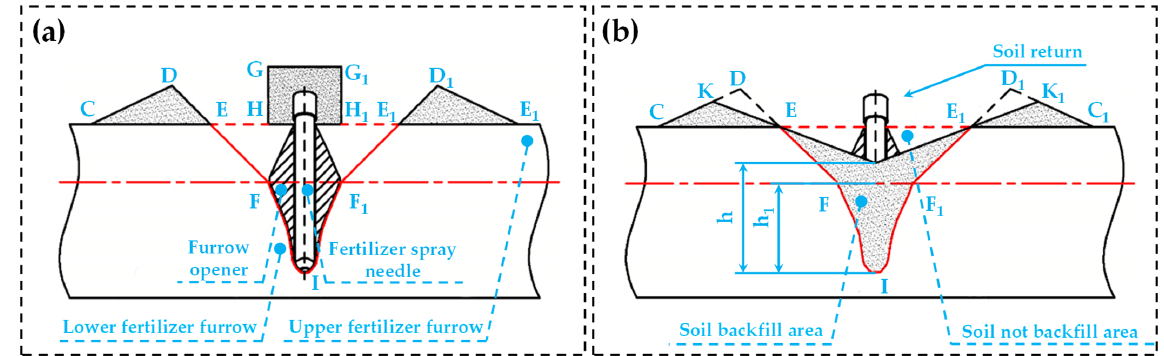
Figure 10. Schematic diagram of soil-returning behavior of high-efficiency soil-returning liquid-fertilizer deep-application furrow opener. ( a ) Schematic diagram of soil disturbance behaviors. ( b ) Schematic diagram of the soil-return principle.